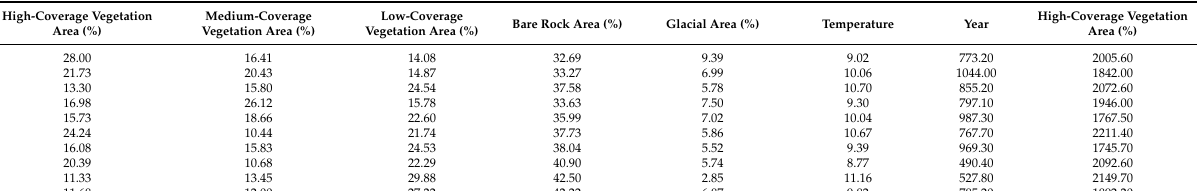
Table 3. Landscape classification and climate change indicators in Sobchaye.